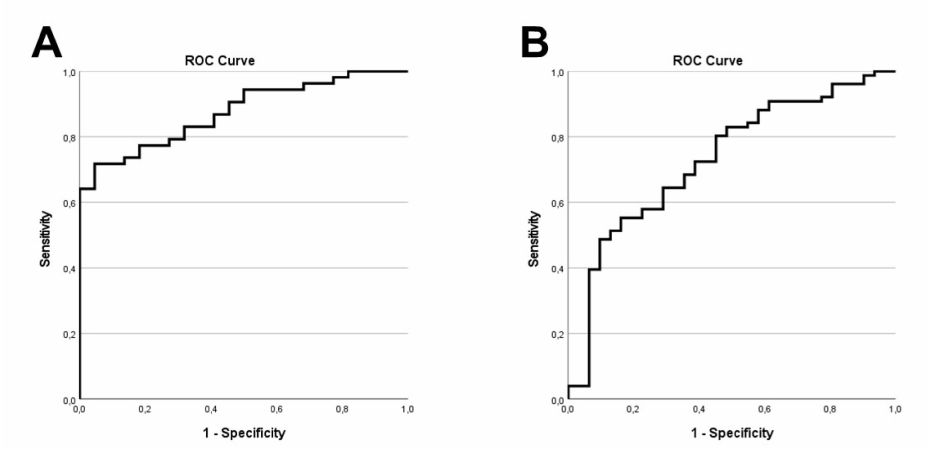
Figure 1. ROC curves of two probability prediction models of the olfactory outcome. Probabilities were calculated based on Binary Logistic Regression models. ( A ) age, gender, disease duration, Multiple Sclerosis disease type, EDSS score, smoking status, SDMT, GVLT, BVMT-R, MFIS, BDI, and MSIS were set as independent variables. ( B ) Age, gender, disease duration, MS type, EDSS score, and smoking status were set as independent variables. EDSS: Expanded Disability Status Scale; SDMT: Symbol Digit Modalities Test; GVLT: Greek Verbal Learning Test; BVMT-R: Brief